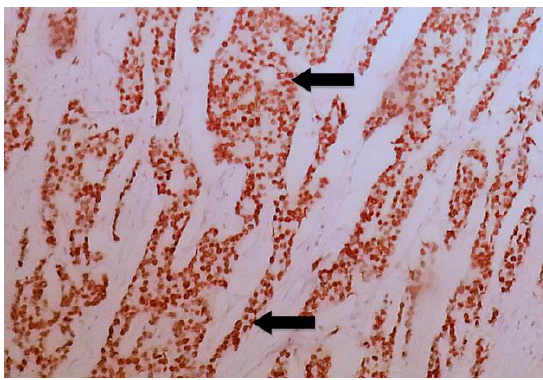
Fig. 5. Invasive Ductal Carcinoma of Breast with HER2 Immunohistochemistry Score 2+ (equivocal) Showing Weak-Moderate Complete Circumferential Brown Membranous Staining (arrows) in >10% of Invasive Cancerous Cells (60X).